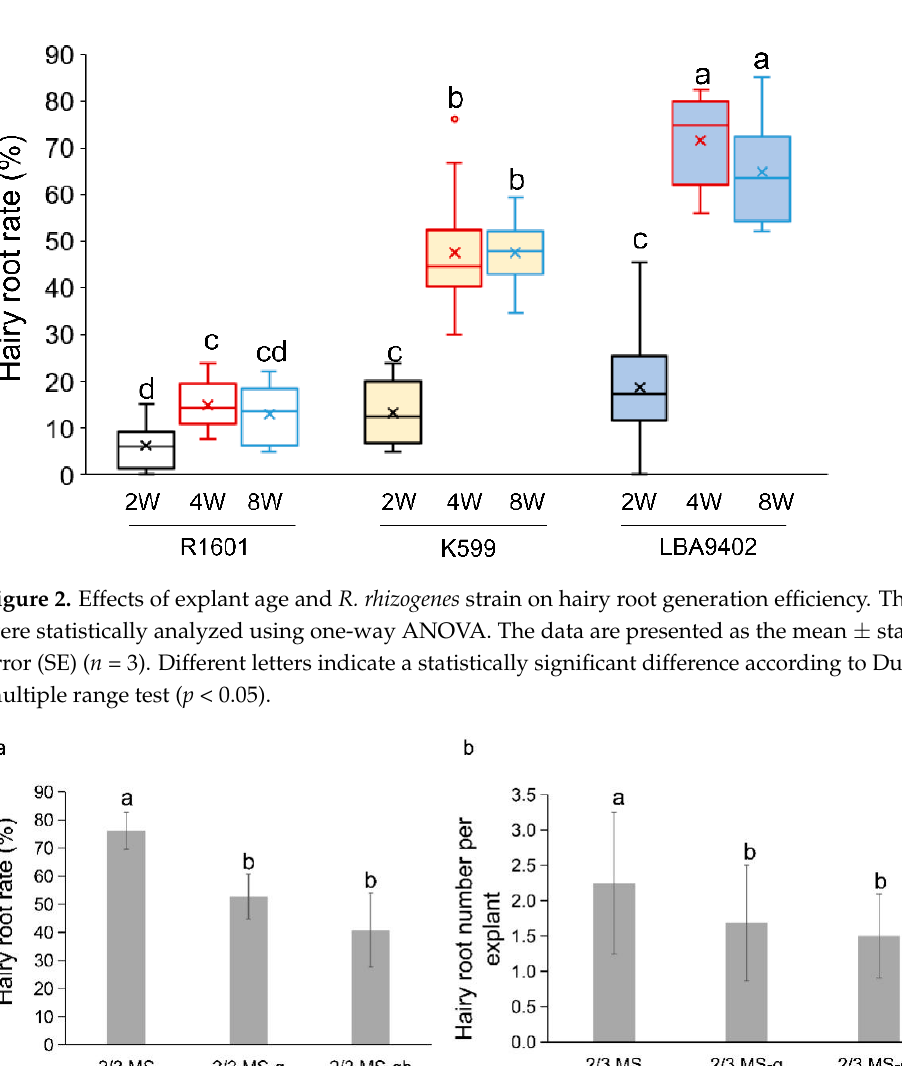
Figure 3. Effects of medium supplements on the R. rhizogenes strain LBA9402 hairy root induction: ( a ) effects of medium supplements on hairy root generation efficiency; ( b ) number of hairy roots that emerged per leaf disc on different media. The data are presented as mean ± standard error (SE) ( n = 3) and were statistically analyzed using one-way ANOVA. The comparison of treatments was conducted using Duncan’s multiple range test ( p < 0.05). Different letters indicate a statistically significant difference ( p < 0.05).